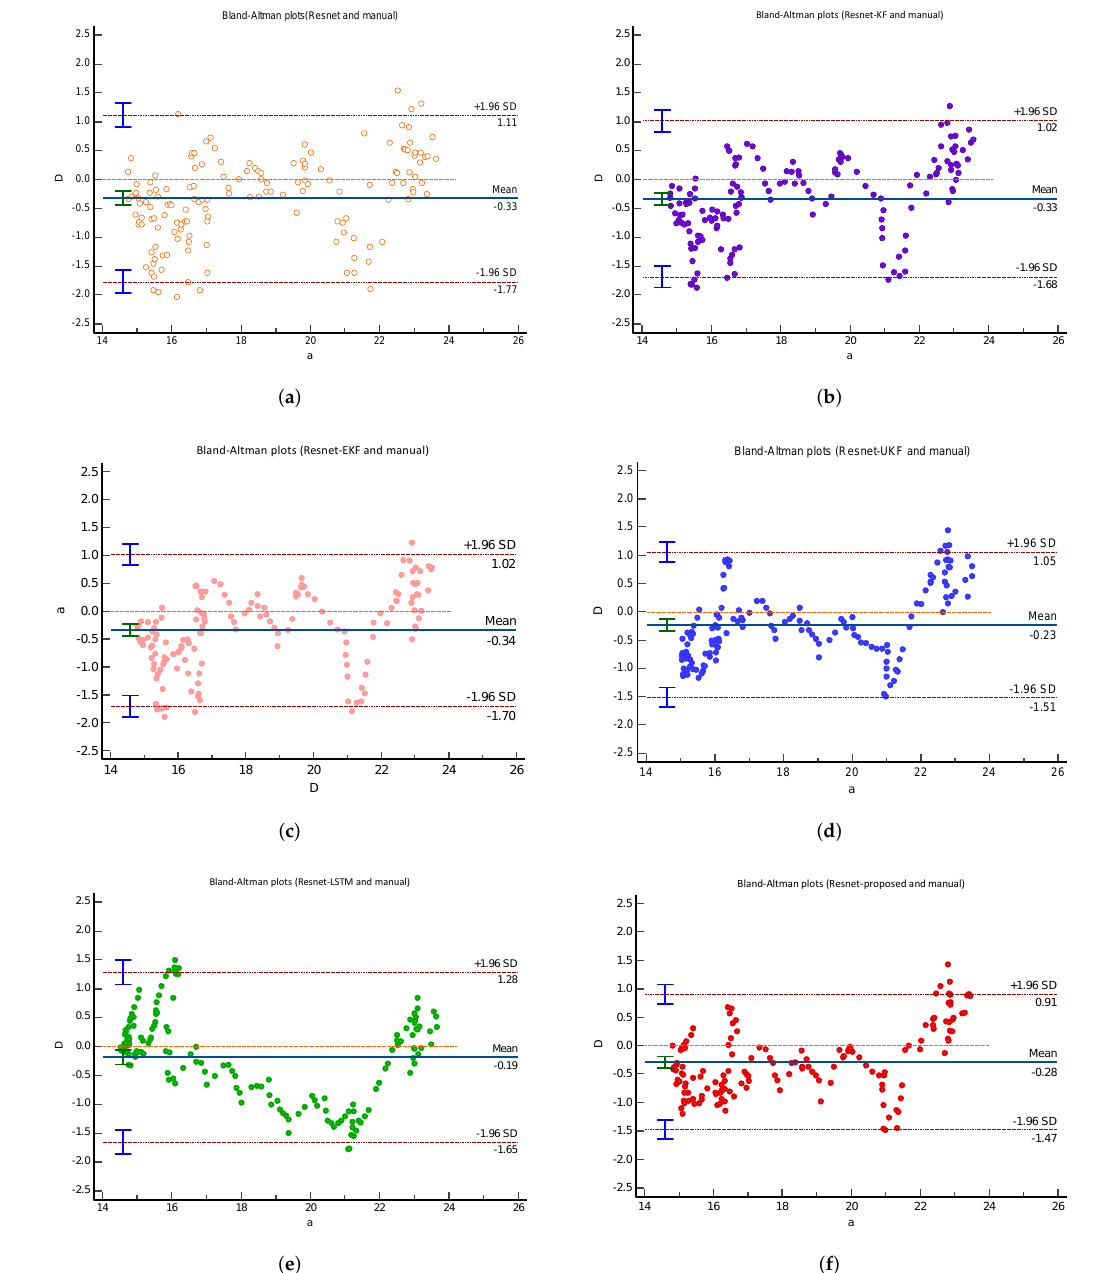
Figure 6. Bland–Altman plots comparing the manually annotated results with the results obtained by the five methods on Subject 3. ( a – f ), respectively, represent Bland–Altman plots comparing the manually annotated results with the results obtained by the six methods on Subject